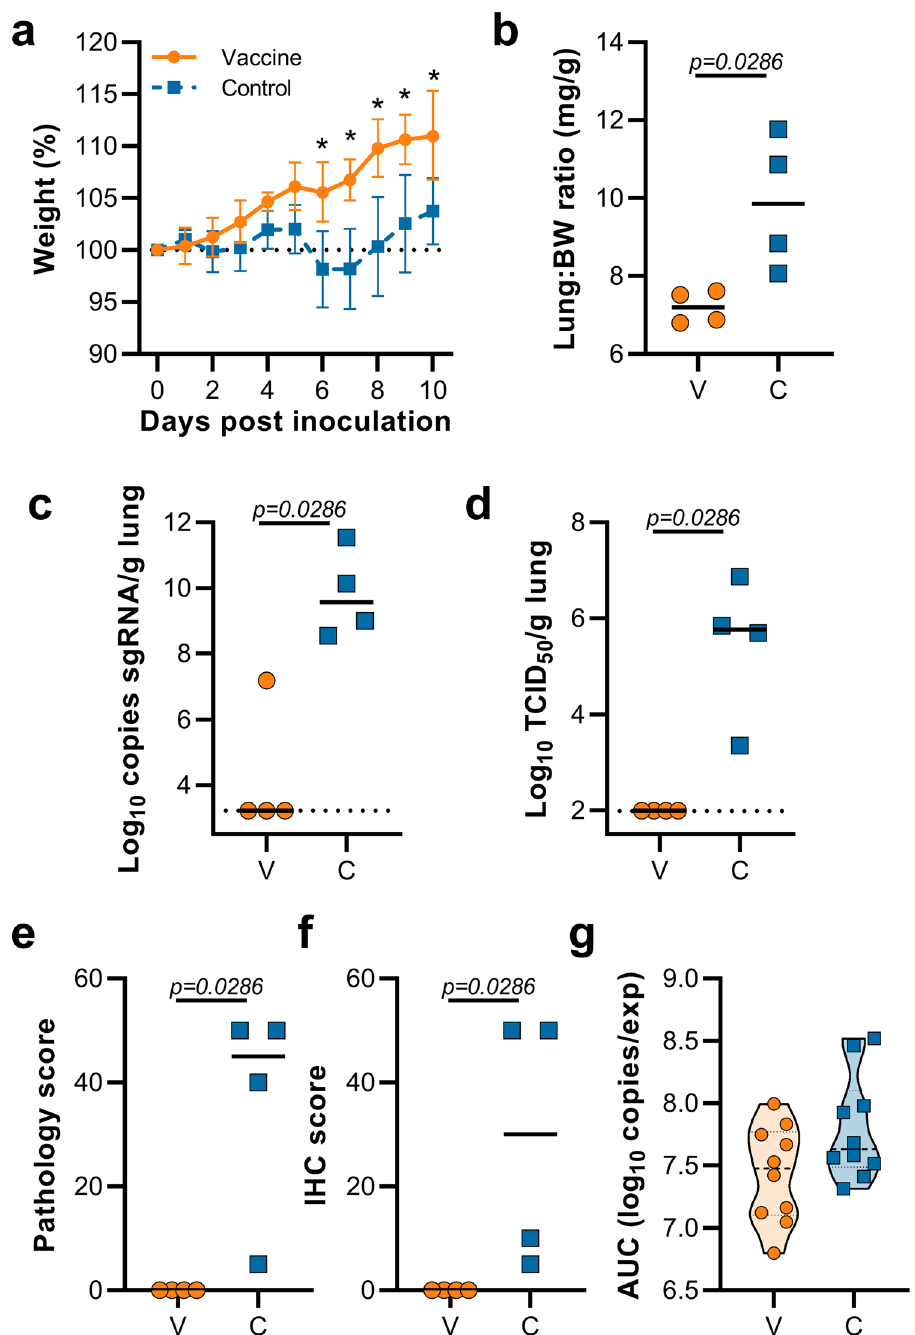
Fig. 4 Vaccination of Syrian hamsters with ChAdOx1 nCoV-19 prevents lower respiratory tract infection with SARS-CoV-2 VOC B.1.351. a Relative weight upon intranasal challenge with 10 4 TCID 50 of B.1.351. Shown is the geometric mean with a 95% con fi dence interval (CI). * p -value < 0.005, corrected for multiple comparisons using the Holm – Š idák correction. b Lung:body weight (BW) ratio (mg:g) of hamsters euthanized at 5 DPI. Line = median. c sgRNA viral load in lung tissue obtained at 5 DPI. Line = median. Dotted line = limit of detection. d Infectious SARS-CoV-2 titer in lung tissue obtained at 5 DPI. Line = median. Dotted line = limit of detection. e Percentage affected lung tissue per animal as determined via histology. Line = median. f Percentage of lung tissue positive for SARS-CoV-2 antigen per animal. Line = median. g Truncated violin plot of area under the curve (AUC) analysis of shedding as measured by sgRNA analysis in swabs collected on 1 – 5 DPI. Dashed line = median. Dotted line = quartiles. Statistical signi fi cance determined via multiple student t -tests with an n of 10 biologically independent animals ( a ), or two-tailed Mann – Whitney test ( b – e ) with an n of 4 biologically independent animals and ( g ) with an n of 10 biologically independent animals. p -values for days 6, 7, 8, 9, and 10 are 0.000004, <0.000001, <0.000001, <0.000001 and 0.000007, respectively. V = ChAdOx1 nCoV-19 vaccinated; C = ChAdOx1 GFP vaccinated; Orange circle = Hamsters vaccinated with ChAdOx1 nCoV-19, Blue square = Hamsters vaccinated with ChAdOx1 GFP.